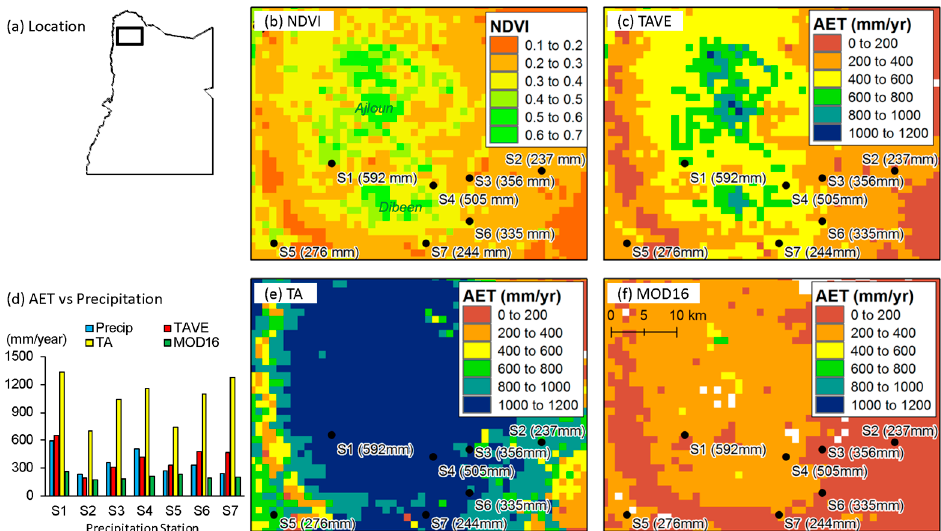
Figure 12. Comparison of different annual AET estimates for a forest region in 2009. ( a ) shows the location of this region within the study area. ( b , c ) show the annual average NDVI and the AET estimates by TAVE, respectively. ( d ) compares the AET estimates with precipitation records at seven weather stations. ( e , f ) show the AET estimates by TA and MOD16, respectively. The black dots in ( b ), ( c ), ( e ), and ( f ) show the locations of weather stations and their annual precipitation.